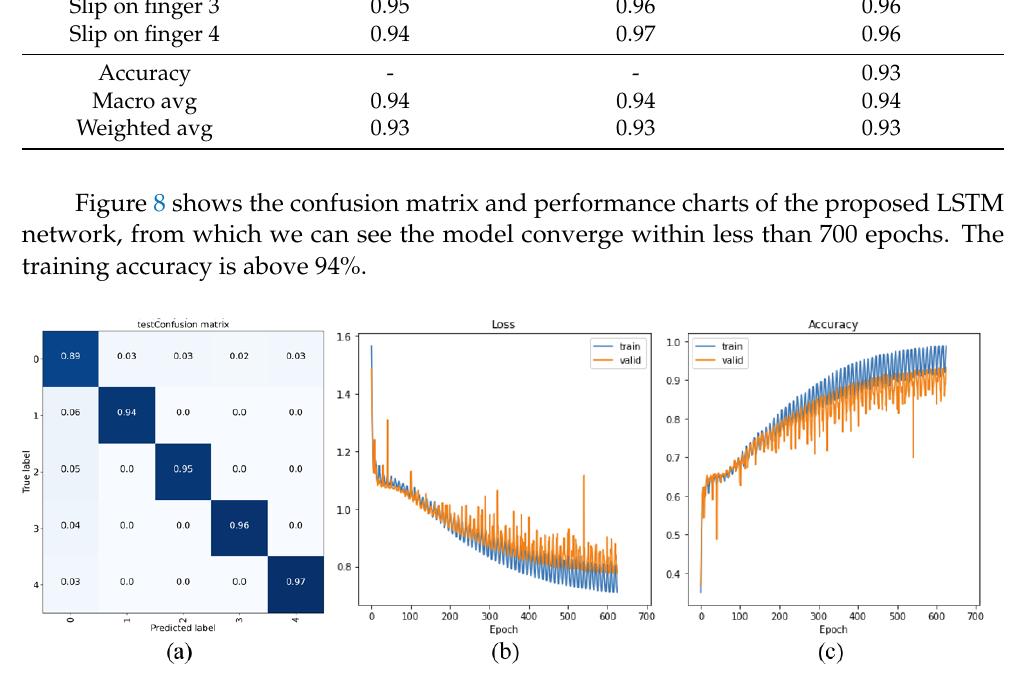
Figure 8. Performance of the proposed LSTM network.( a ) Confusion matrix; ( b ) Epoch-Loss graph; ( c ) Epoch-Accuracy